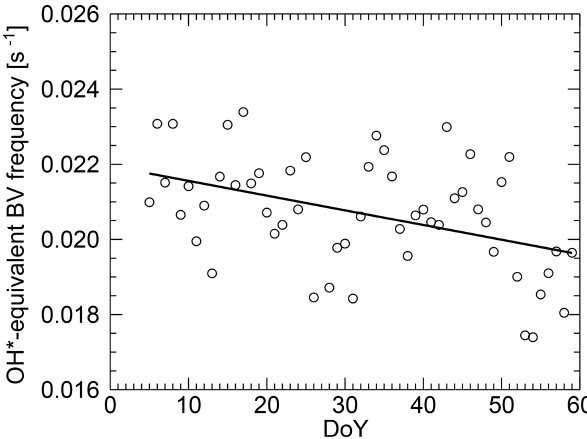
Figure 5. Overall, the OH*-equivalent (angular) Brunt–Väisälä (BV) frequency (circles are individual values) derived from SABER decreases from DoY 1 to 60 in 2016 over ALOMAR. The mean dif- ference between the linear fit and the daily OH*-equivalent (angu- lar) Brunt–Väisälä frequency is ca. 5%.